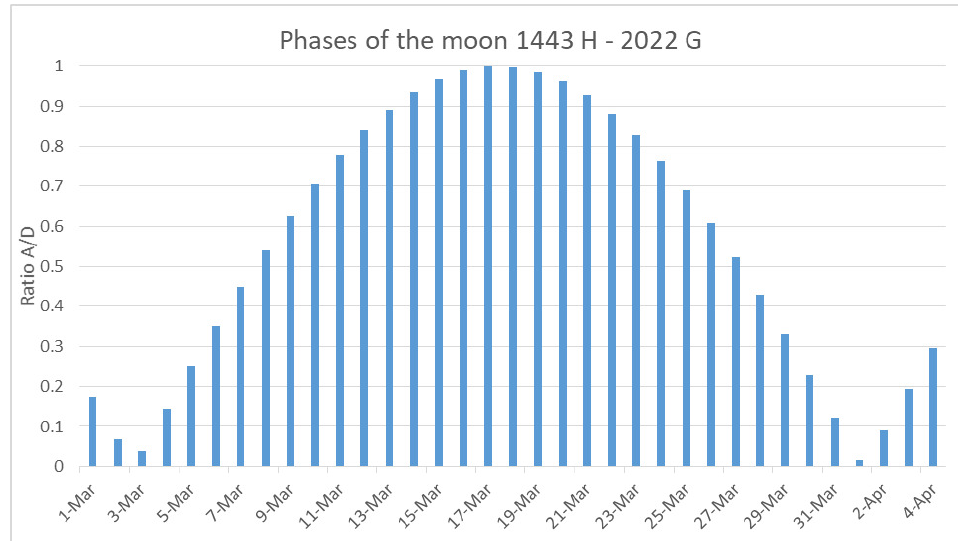
Figure 3a. The Moon’s phases of the March 2022.